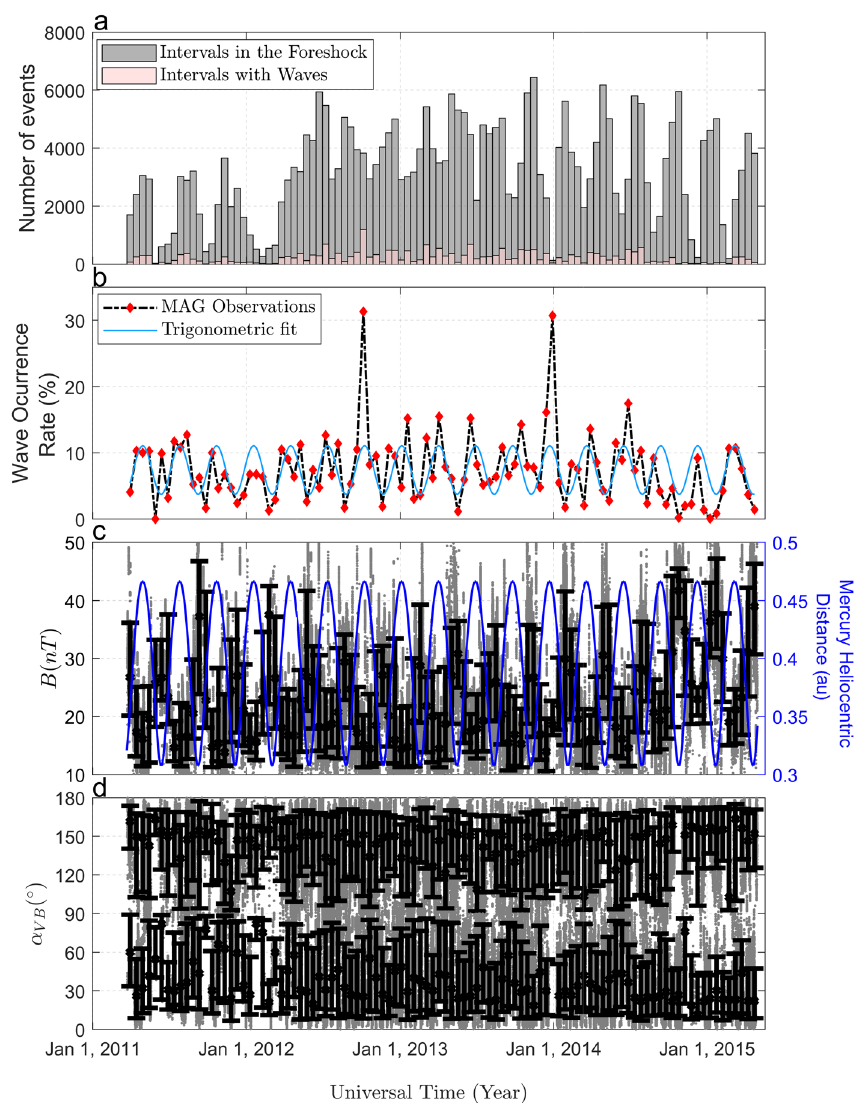
Fig. 6 Wave occurrence as a function of time. a Histograms of the number of selected intervals in the Hermean foreshock (gray) and with wave detection (pink) as a function of time when r = 2, λ 23 = 0; b Associated wave occurrence rate as a function of time based on Magnetometer observations, and best trigonometric fi t (light blue); c , d Interplanetary Magnetic Field intensity and cone angle as a function of time, for all intervals in the Hermean foreshock (in gray), black vertical bars correspond to the 10th, 50th, 90th percentiles for 15-day bins; ( c , right vertical axis) Mercury ’ s heliocentric distance as a function of time (in blue). r is a factor associated with the intensity of magnetic fi eld power spectral density at the wave frequency range of interest, and λ 23 constitutes a threshold for the intermediate to minimum eigenvalue ratio associated with Minimum Variance Analysis. The reader is referred to Eqs. (1) – (3) for a strict de fi